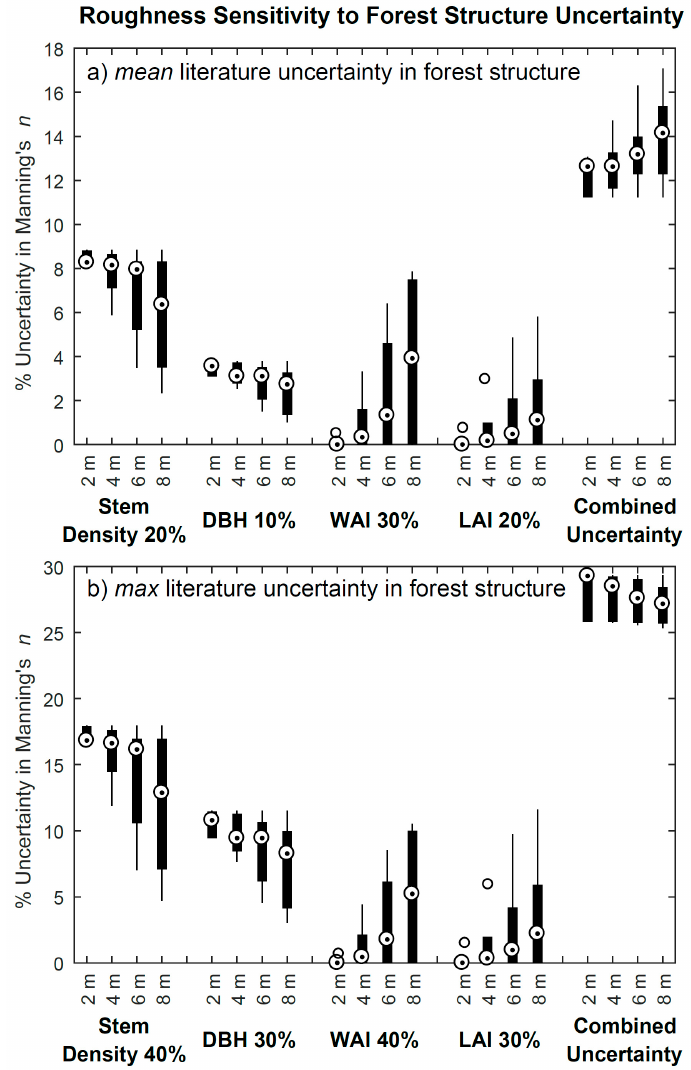
Figure 3. Uncertainty of Manning’s n roughness to ( a ) mean literature errors and ( b ) max literature errors in forest structural variables. Forest structure variables varied are stem spacing, the diameter at breast height (DBH), the branching or Wood Area Index (WAI), and the Leaf Area Index (LAI). Results are shown at four flow depths of 2, 4, 6, and 8 m, with variances in each boxplot due to the forest types. In both panels ( a ),( b ) the uncertainties in the structural variables are combined to illustrate total calculated roughness uncertainty.